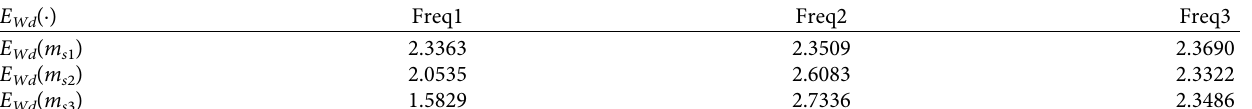
Table 6: Weighted belief entropy of sensor reports under different